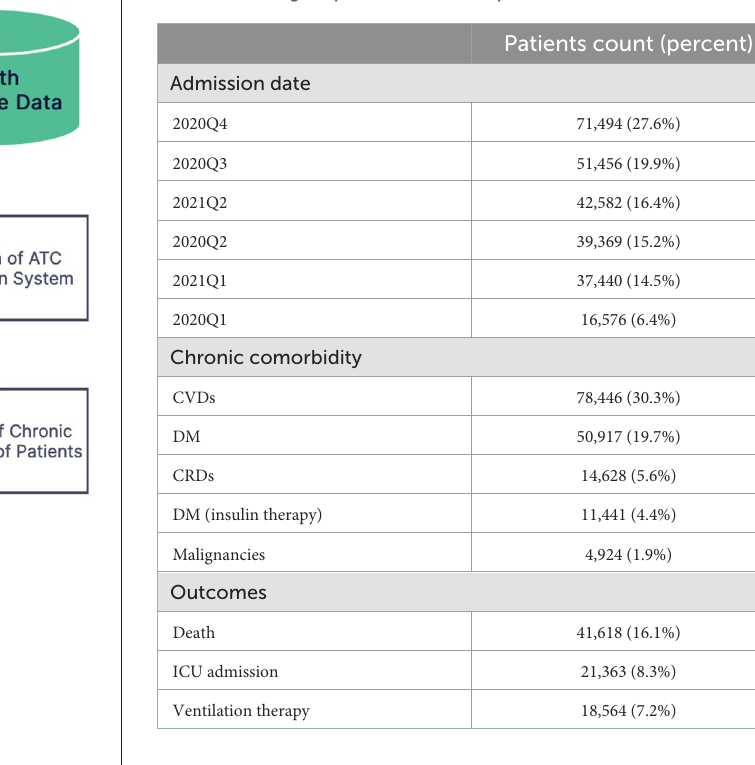
TABLE 1 Distribution of admission dates, chronic comorbidities, and outcomes among hospitalized COVID-19